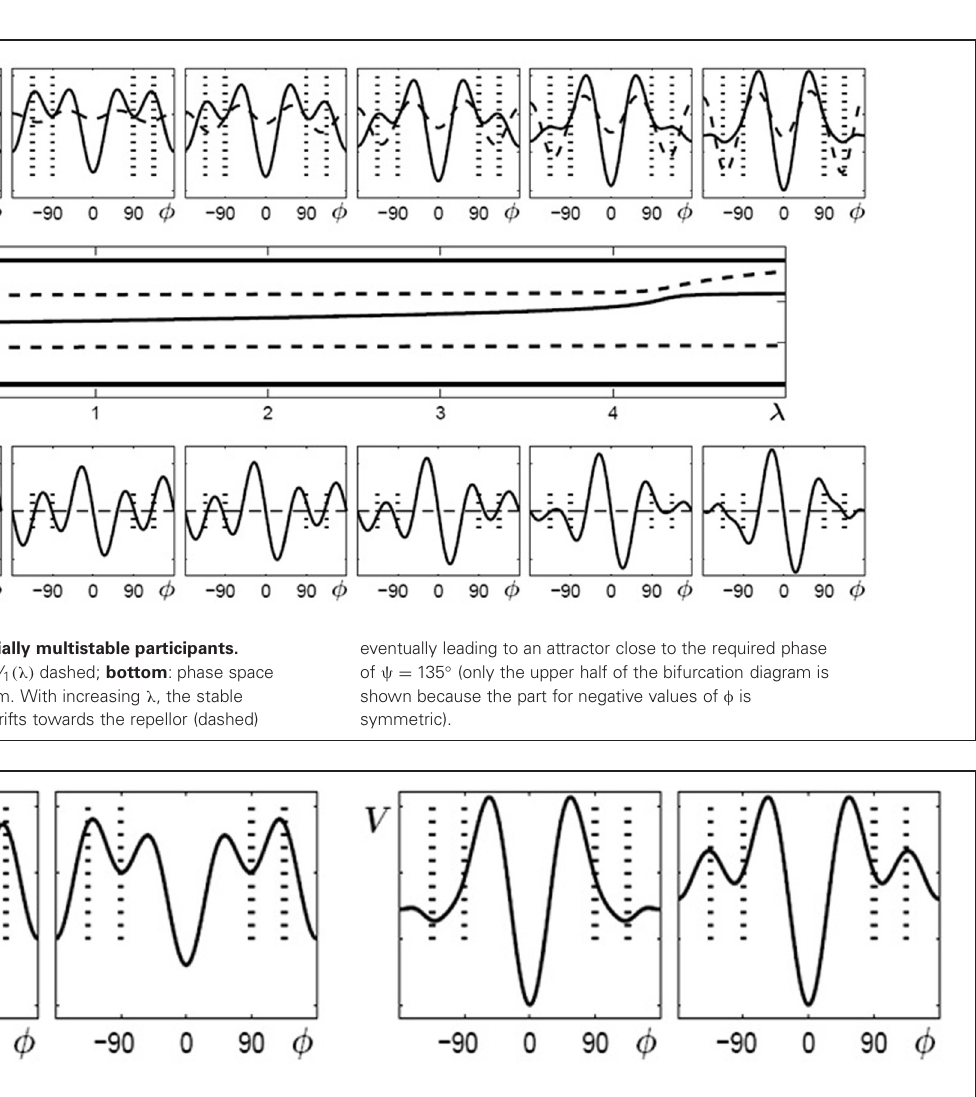
FIGURE 6 | Reorganization of potential landscapes when learning (or practice) has not taken place for some time. Left part : bistable participants, where the minima at ± 90 ◦ that were created during learning